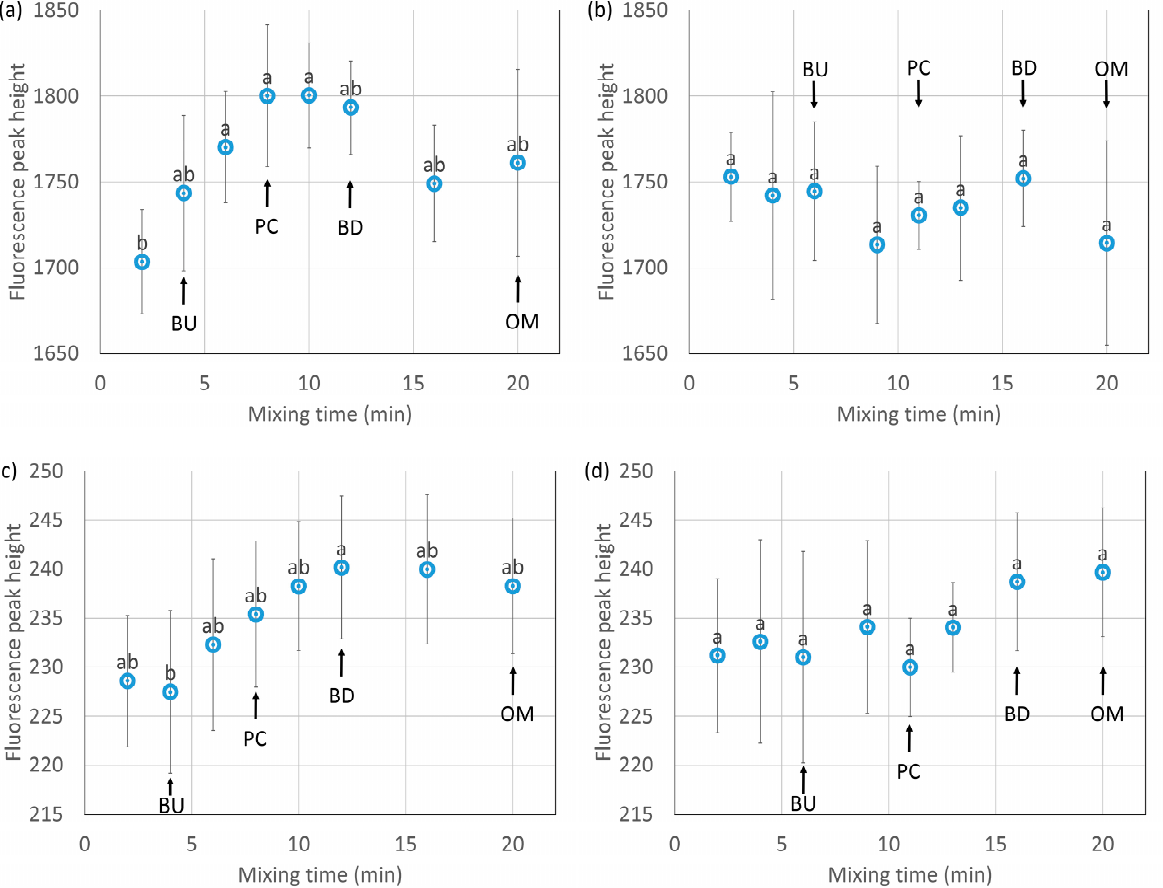
Figure 8. Changes in the fluorescence intensity of the dough with the addition of 8-anilino-1-naphthalene-sulfonic acid ( a , b ) or thioflavin T ( c , d ) during mixing from high-protein flour (HF) ( a , c ) and low-protein flour (LF) ( b , d ). BU, PC, BD and OM indicate buildup, peak consistency, breakdown, and overmixing, respectively. The error bars show standard deviations ( n = 6). Different letters on the graph indicate significant differences ( p < 0.1).